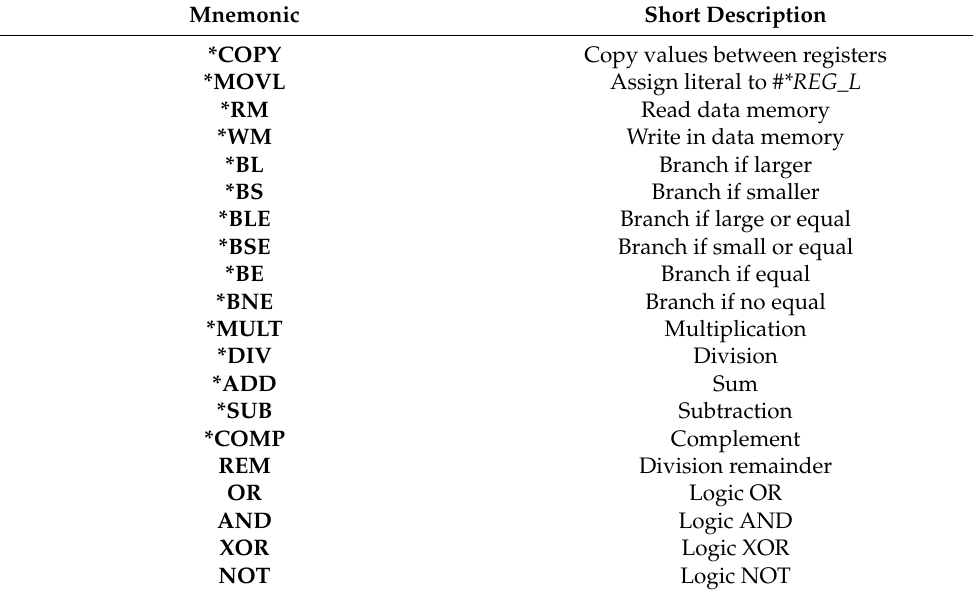
Table 2. Operative instruction